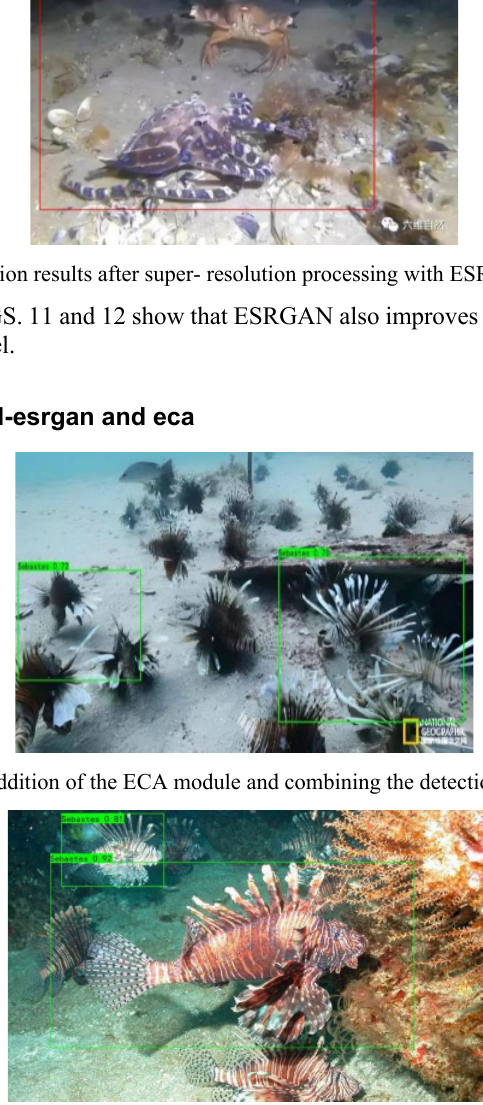
Fig. 14. YOLOX the addition of the ECA module and combining the detection results of